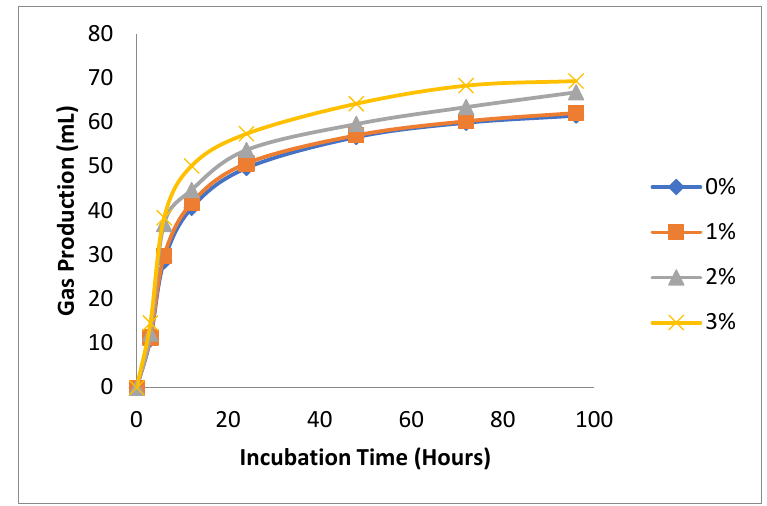
Figure 1. Effects of NaOH treatment on the in vitro gas production of reed straw.